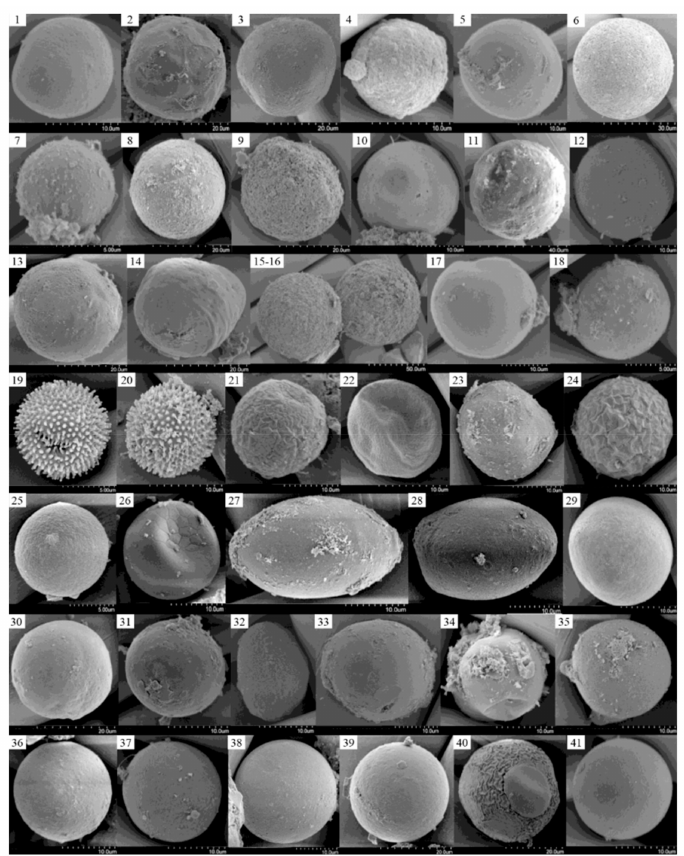
Figure 3. Scanning electron microscopic micrographs of cysts from Samples 9055 (1–18), 9059 (19–26), 9067 (27–32) and 9071 (33–41). Except for Scrippsiella sp. (19 and 20), all other cysts were not convincingly identified due to the absence of both identification references and diagnostic